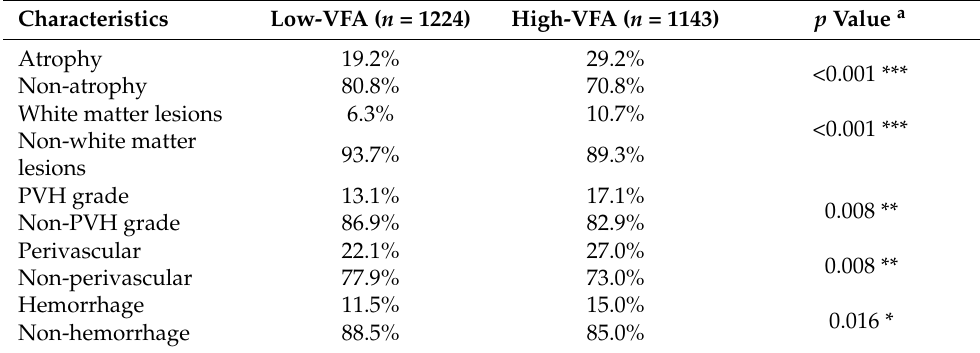
Table 3. Incidence of each brain disorder according to VFA.